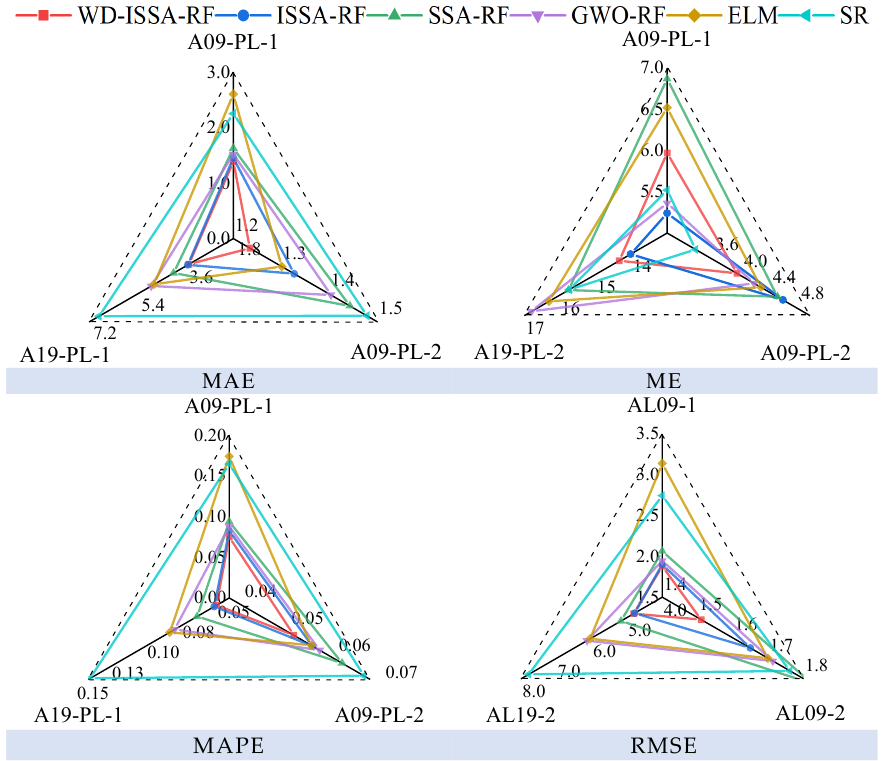
Figure 11. Comparison of prediction performance using six prediction models for three monitoring points.